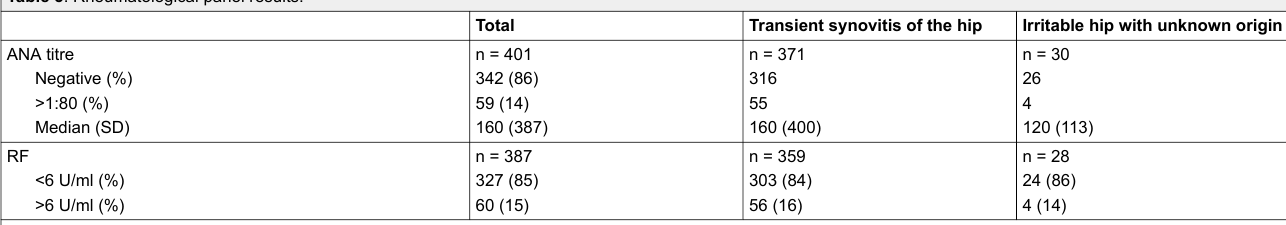
Table 3 : Rheumatological panel results. Total Transient synovitis of the hip Irritable hip with unknown